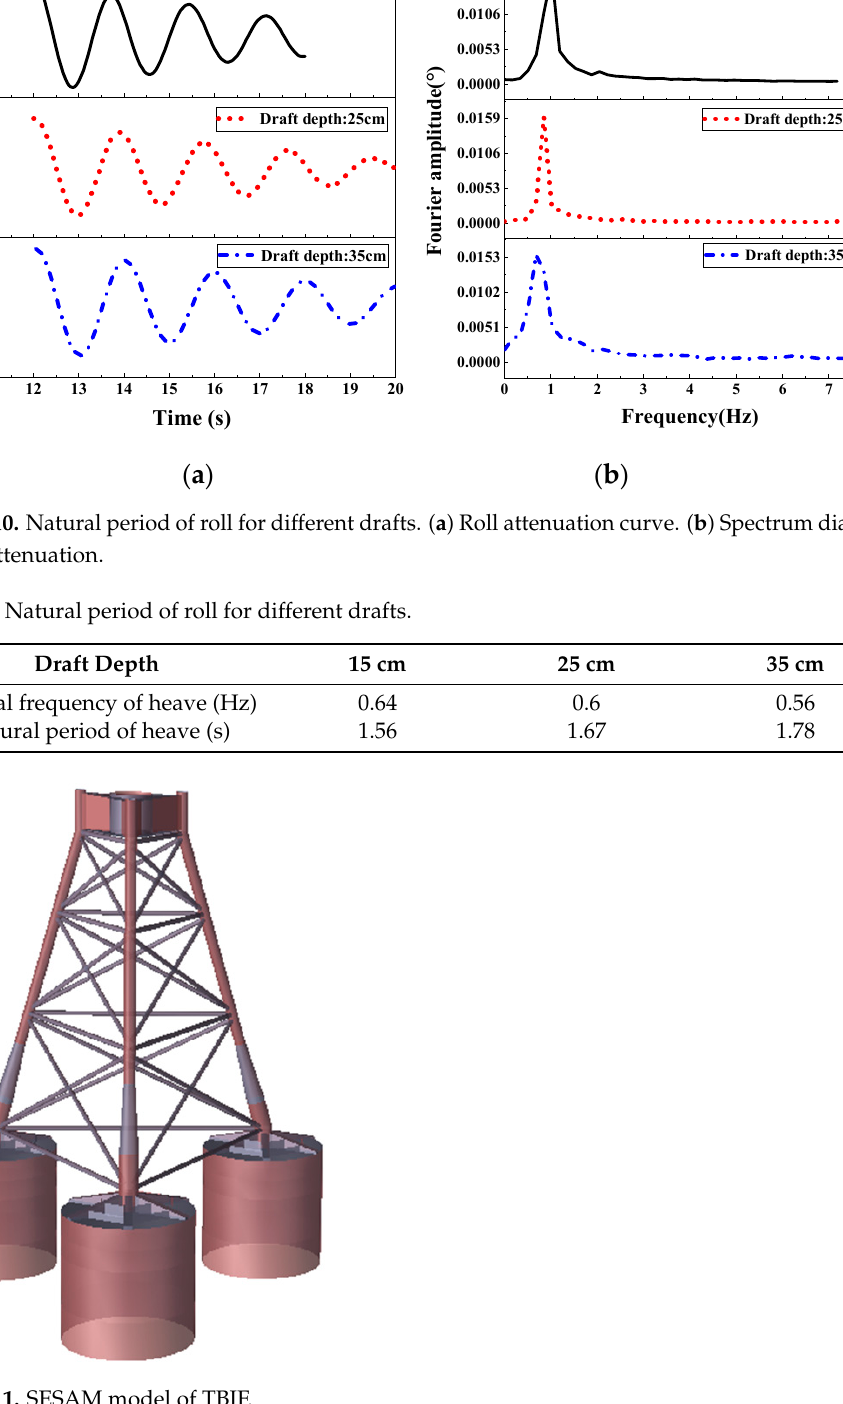
in draft depth was achieved by adjusting the water–air ratio in the bucket. The motion